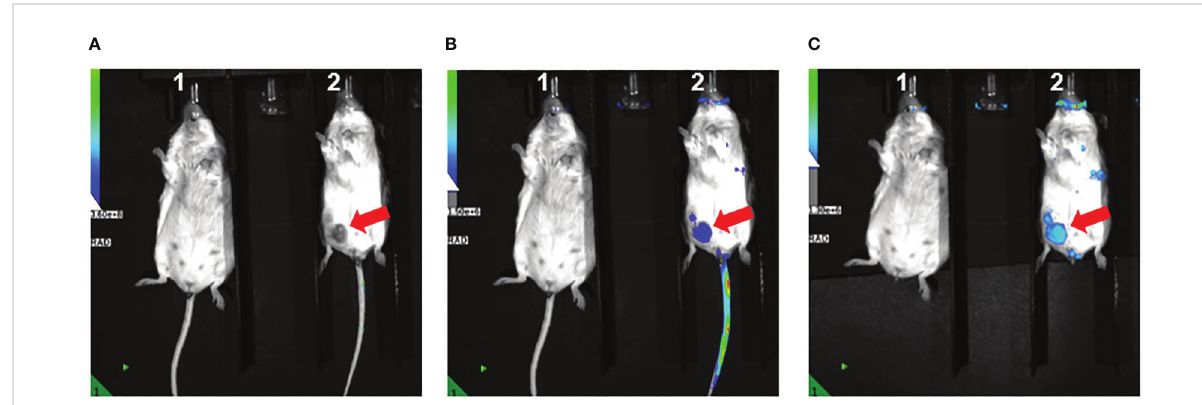
FIGURE 6 RAW.264.7 M1 polarized vesicles localize to Caov-3 tumor xenografts in vivo . (A) Two BALB/c-SCID mice displayed – one without tumor (left) and one with visible tumor (right) marked by the arrow. The mouse on the right was injected with 100 µl of fl uorescent dye-labeled vesicles and imaged 72 hours post-injection. The fl uorescent overlay was reduced to display visible tumor for comparison (B) Same mice shown in A with clear fl uorescent uptake seen in the vicinity of the tumor in the right lower quadrant displayed in Image (A, C) Tail veins covered to reduce emission background, displaying accentuated M1 MEV localization to the